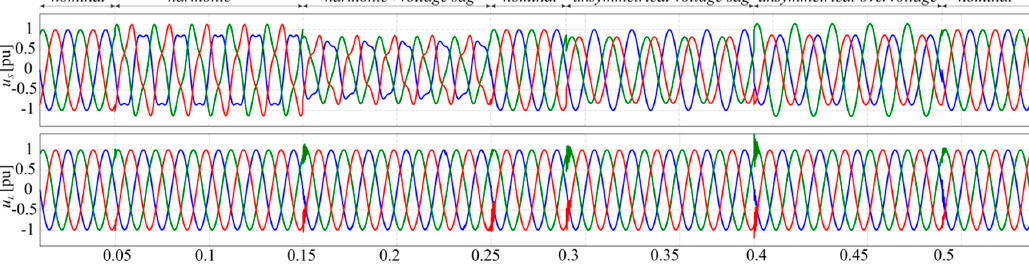
Figure 19. Results of compensations of electric power grid voltage fluctuation using an HT with an MC and MPC control (author’s simulation results); red – voltage phase 1, blue – voltage phase 2, green – voltage phase 3.